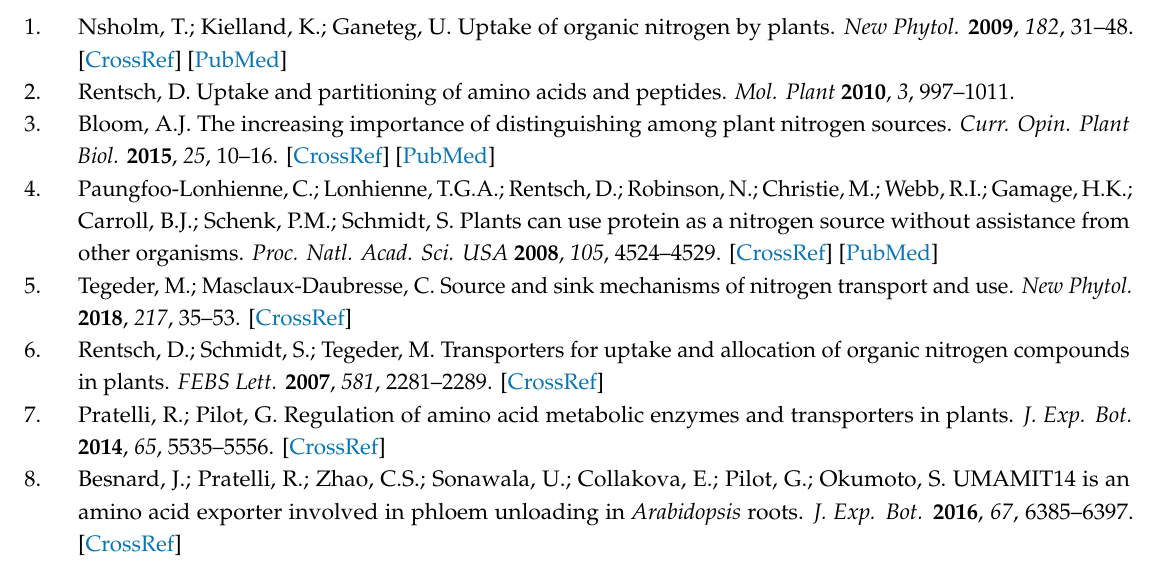
Table S1: References about the roles of the amino acid transporters mentioned in Figure 1. Figure S1: Phylogenetic relationship of Arabidopsis and rice amino acid